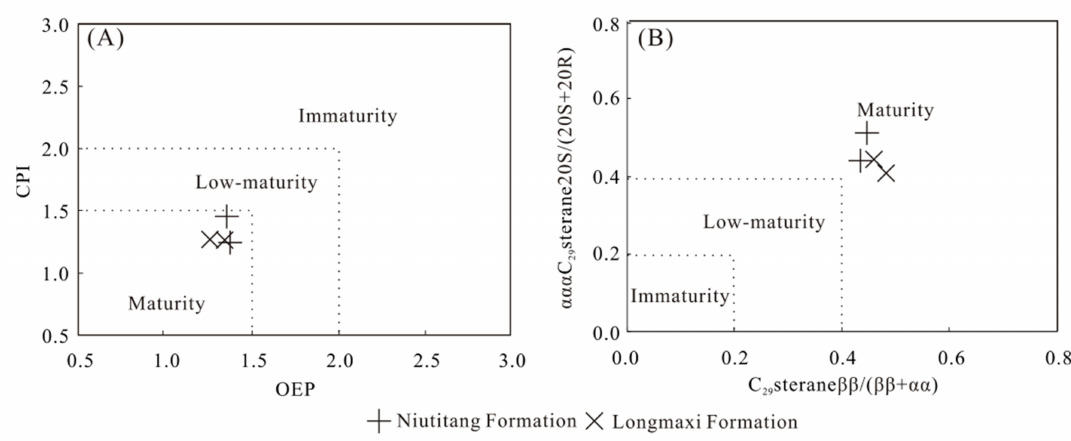
Figure 9. Cross diagrams of OEP versus CPI ( A ), and the C 29 sterane ββ /( ββ + αα ) versus ααα C 29 sterane 20S/(20S + 20R) ( B ). ( A , B ) Base map is from Li et al.